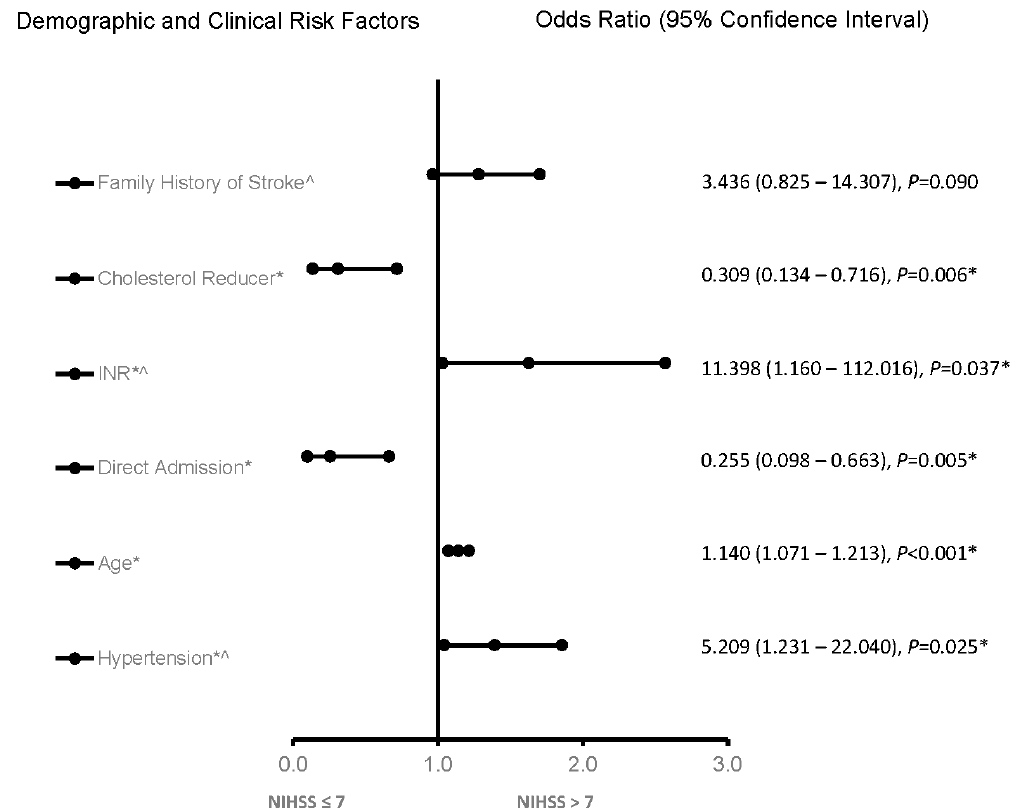
Figure 1. Factors associated with ischemic stroke patients, independent of age, in the telestroke database. Adjusted OR < 1 denotes factors associated with improving neurologic function or NIH ≤ 7. Hosmer–Lemeshow test: p = 0.767; Cox and Snell: R2 = 0.268. The overall classi fi ed percentage of 75.4% was applied to check the fi tness of the logistic regression model. * indicates statistical signi fi cance ( p <0.05) with a 95% con fi dence interval, ^ Indicates that data were modi fi ed by taking the 5th square root.